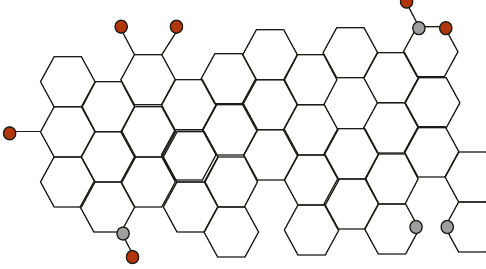
Figure 3: Nanomaterial ladder